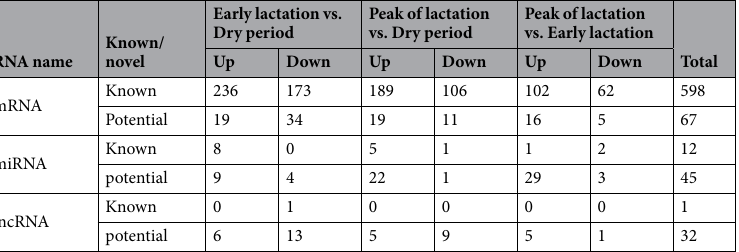
Table 1. Differentially expressed RNAs during dry period, early lactation, and peak of lactation. Up means that the expression of mRNAs, miRNAs, or lncRNAs were up-regulated, and down means the expression of mRNAs, miRNAs, or lncRNAs were